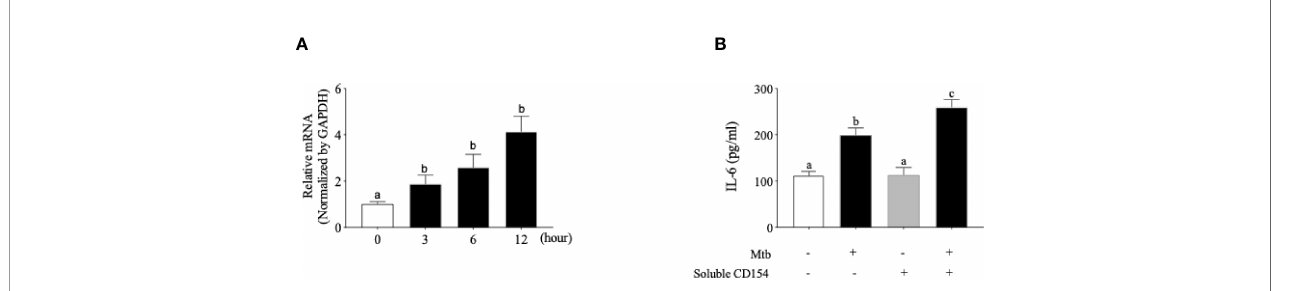
FIGURE 3 | Functional CD40 molecule is induced by Mycobacterium tuberculosis ( Mtb ) infection in human osteoblast cells. (A) Quantitative real-time PCR analysis for CD40 performed on single-stranded cDNA synthesized from the total RNA from Mtb -infected osteoblast cells. (B) Interleukin 6 (IL-6) secretion after ligation of CD40 by soluble CD154 in osteoblast cells. After Mtb infection, osteoblast cells were treated with soluble CD154, and the cell culture supernatant was collected 24 h later for the analysis of IL-6 secretion. The level of IL-6 was measured using a commercially available ELISA kit. Means without a common letter differ. p < 0.05. Groups that do not share a lower case letter are signi fi cantly